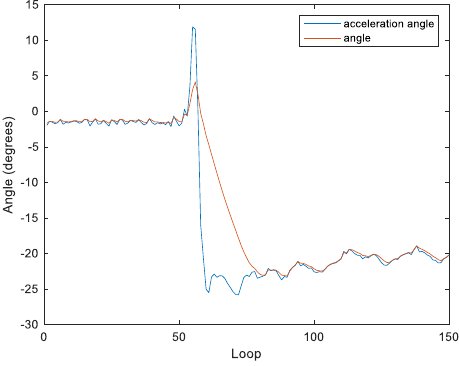
Figure 10. The reliability of the acceleration with R = 2. Figure 10. T he reliability of the acceleration with R = 2. Figure 10. T he reliability of the acceleration with R = 2.